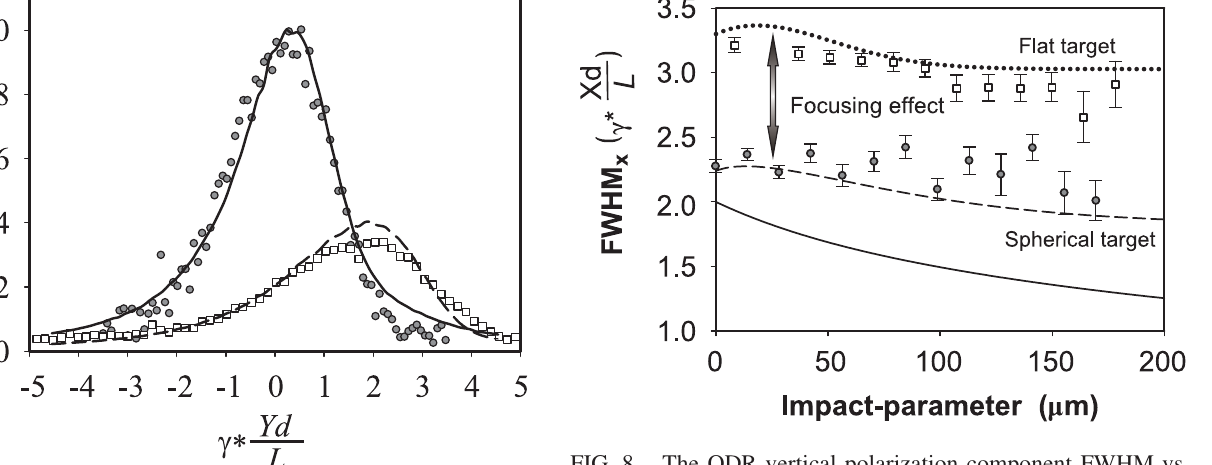
FIG. 7. The ODR vertical polarization component spatial dis- tributions along the Yd direction ( Xd ¼ 0 ). Gray dots—spherical target experiment; white squares—flat target experiment; solid line—spherical target theory; dashed line—flat target theory. The impact parameter is equal to h ¼ 50 (cid:1) m